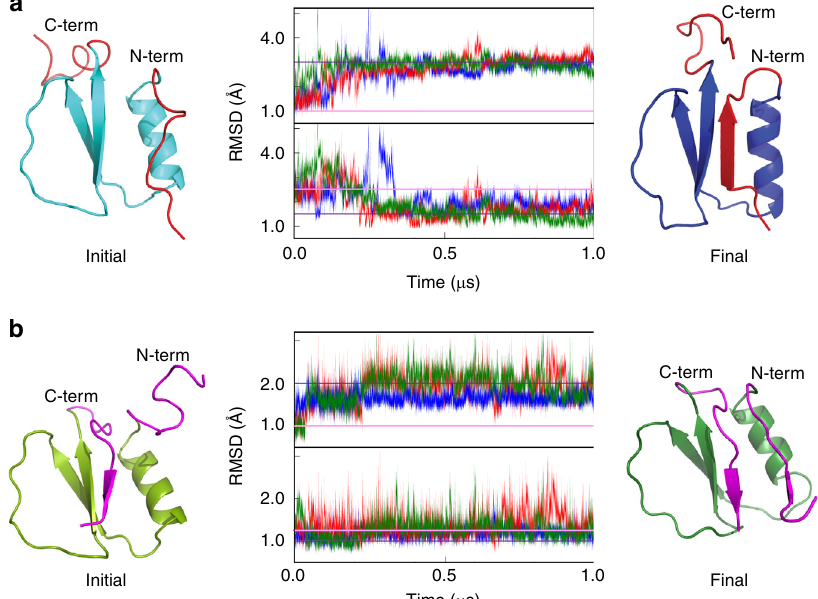
Fig. 5 Structural model of the fold-switched CI2 eng . a MD simulations of a structural model of CI2 in which its C-terminal strand has been unraveled using Modeller. The initial model is shown on the left in cyan with both terminal strands highlighted in red. After multiple 1 μ s-long molecular dynamics trajectories (center, in red, green and blue) the protein consistently transitions onto a fold-switch conformation that corresponds to a basic Rossman fold (shown in blue on the right). b MD simulations of a structural model of CI2 in which its N-terminal strand has been unraveled using Modeller. The initial model is shown on the left in light green with both terminal strands highlighted in magenta. After multiple 1- μ s-long molecular dynamics trajectories (center, in red, green and blue) the protein refolds back to its native structure, as shown in green on the right. For both a , b , RMSD was calculated versus the initial structure (top subpanel) or the average of the three fi nal structures (bottom